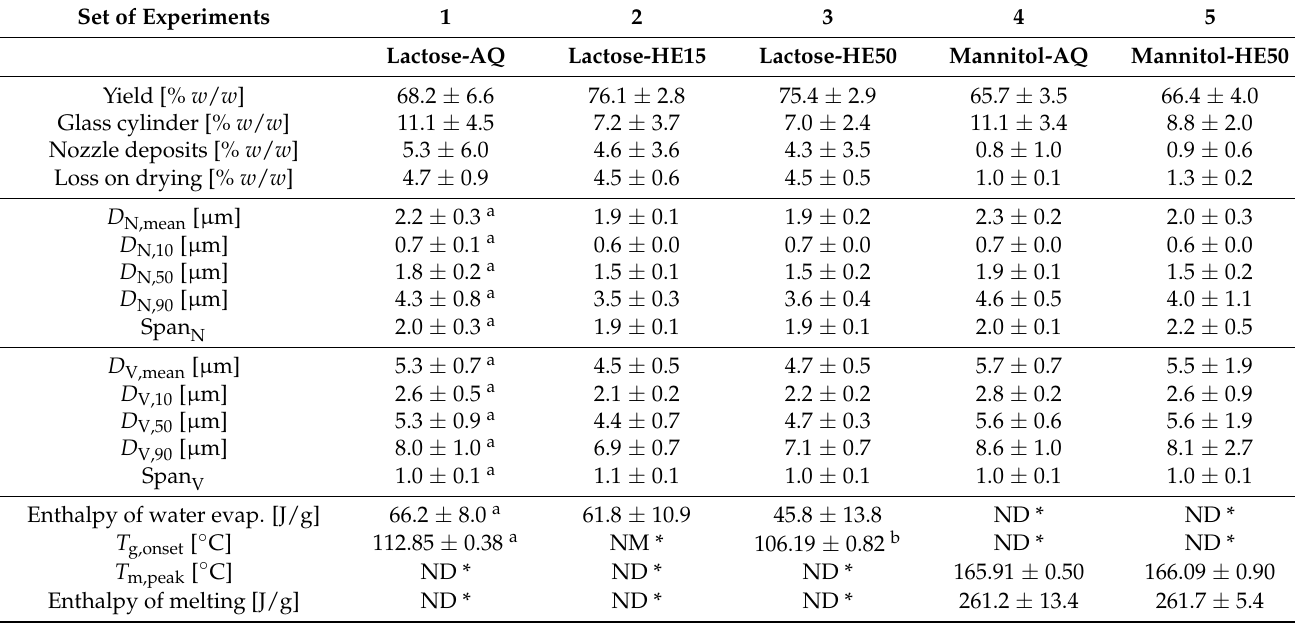
Table 3. Characteristics of nano spray-dried powder